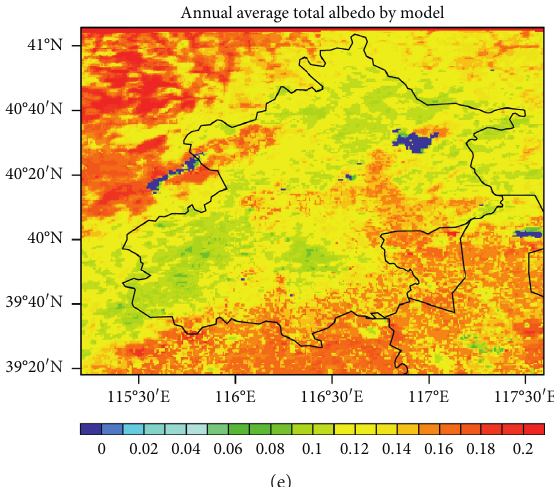
Figure 4: Spatial distribution of the annual (e) and seasonal (a–d) average surface albedo simulations after assimilation in the Beijing municipal